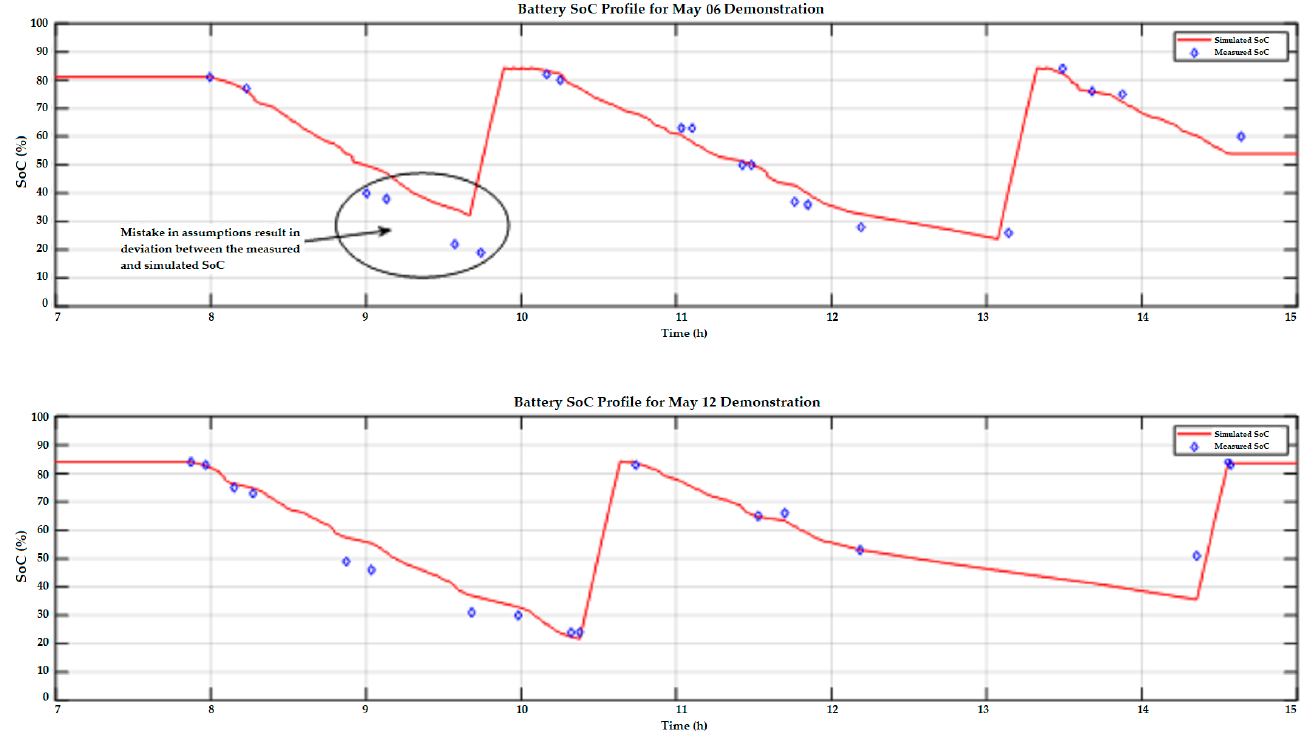
Figure 8. The SoC output profile of the 18m bus subject to the driving and charging scenario in Figure 7 using the estimates given in Table 5, and showing the correlation between the simulated outputs and measured values. Table 6. Estimation of the driving scenario configuration for Gothenburg Table 5. Estimation of the driving scenario configuration for the Osnabruck demonstration. Parameter to Be Estimated